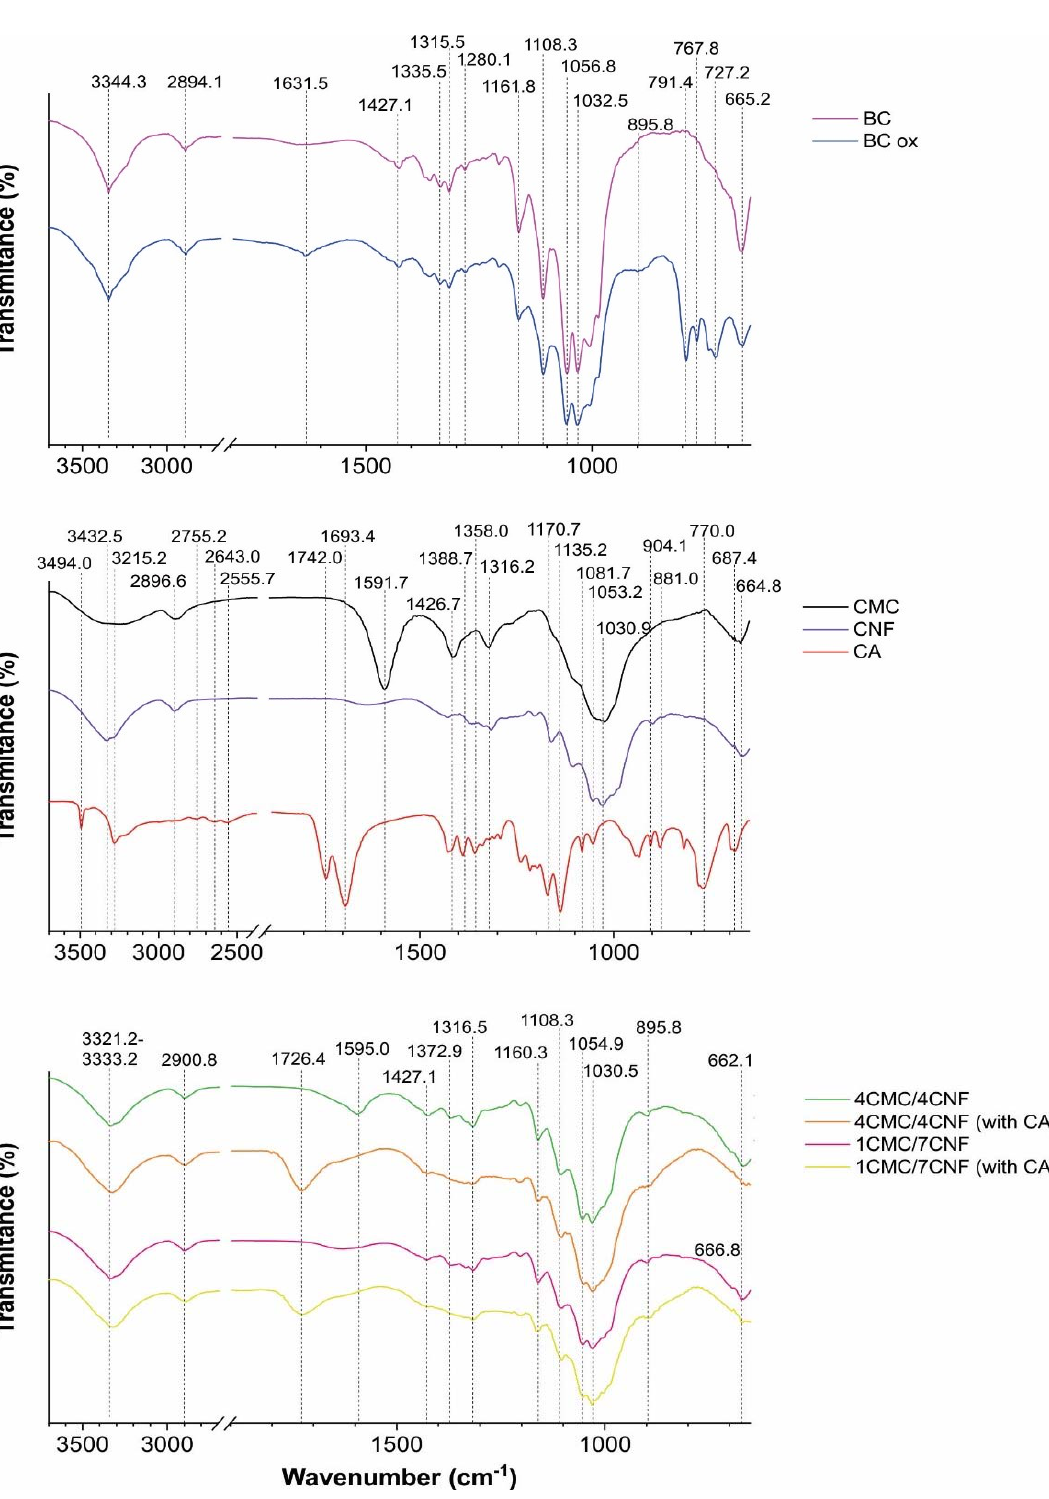
Figure 2. ATR–FTIR spectral lines of components (CMC, CNF, and CA) and cellulose membranes. BCox is the designation of the BC membrane after NaIO 4 treatment. The CNF/CMC membranes with different mass ratios of components (4/4 and 7/1) and the addition of 5 % CA are accordingly